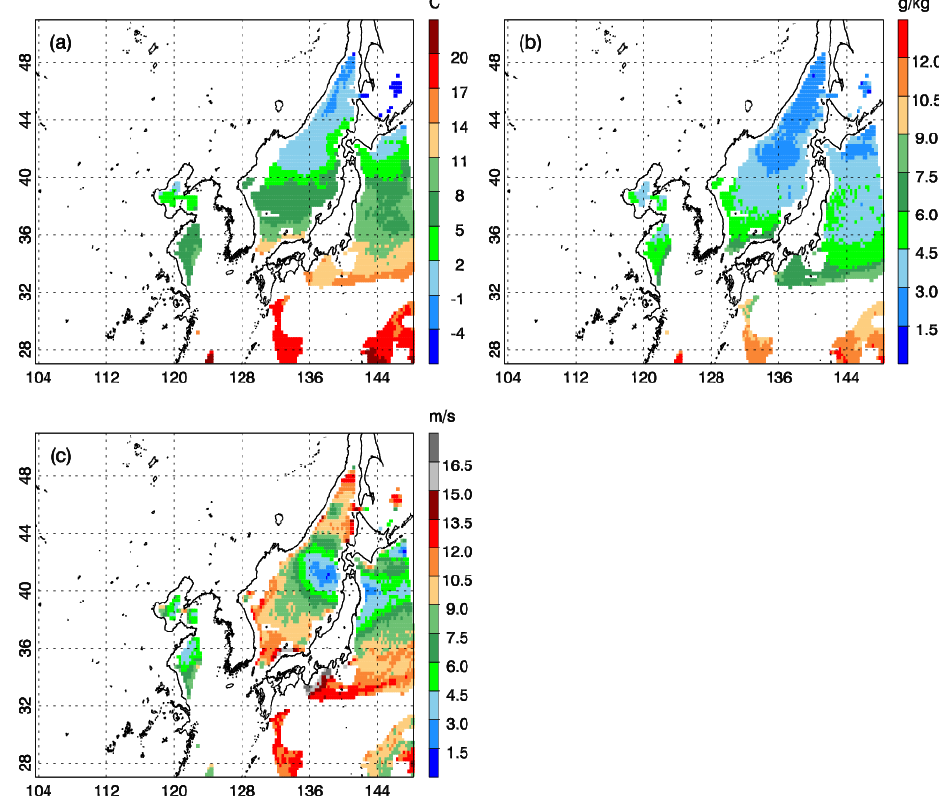
Figure 1. A sample plot of the GPM-retrieved ocean surface meteorology data for (a) 2m temperature ( ◦ C), (b) 2m specific humidity (gkg − 1 ), and (c) 10m horizontal wind speed (ms − 1 ) at 09:00UTC 7 March